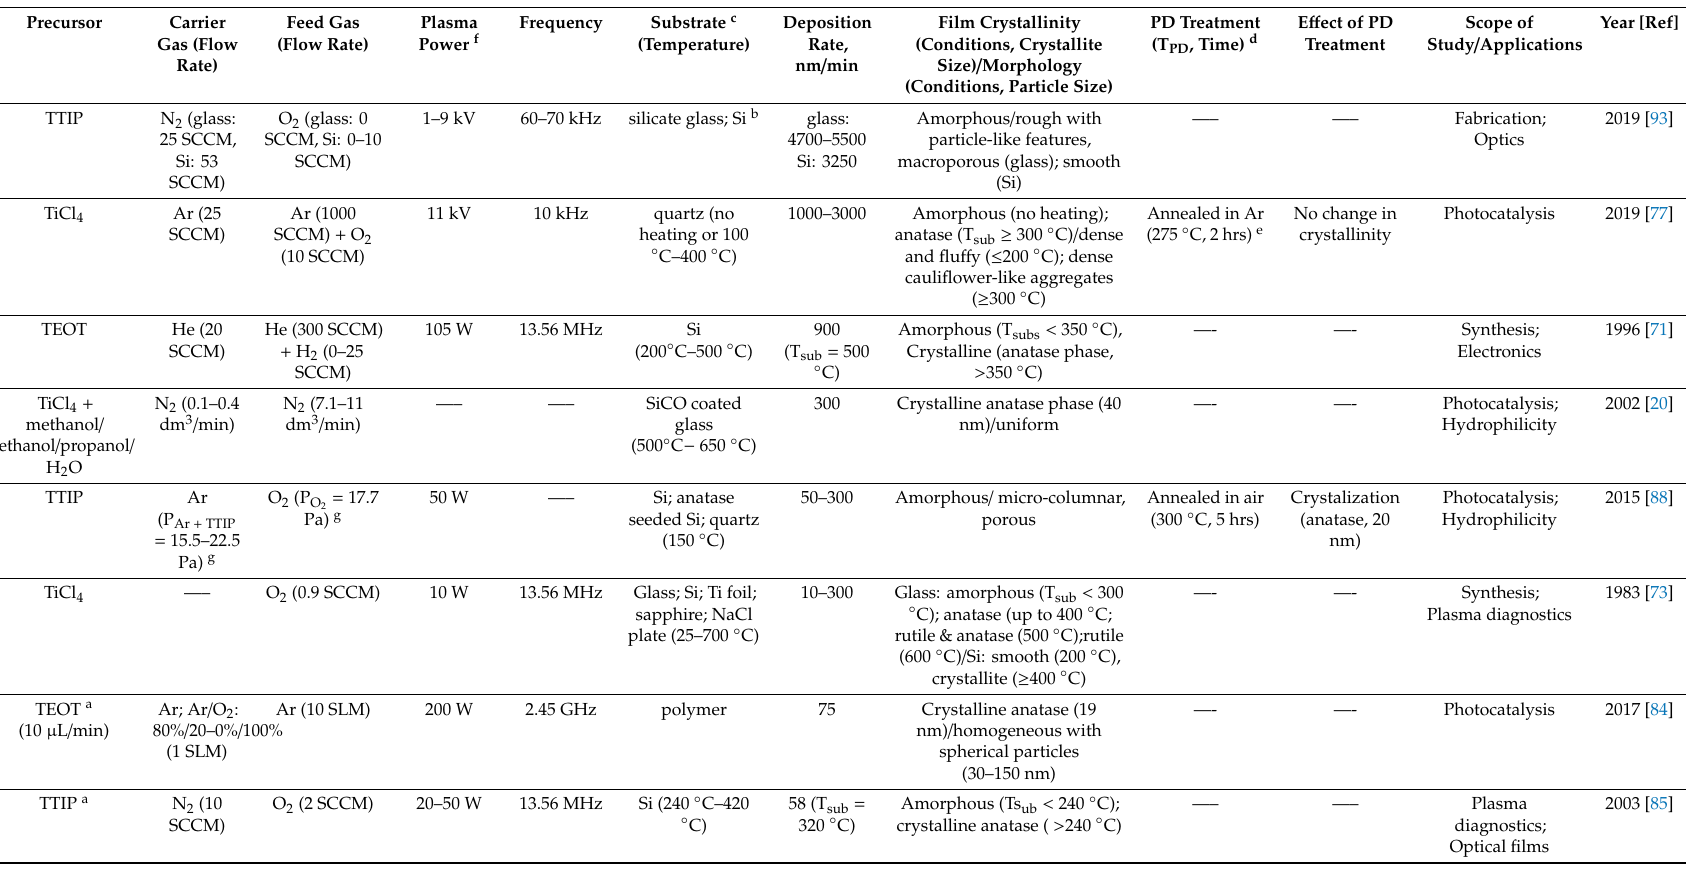
Table 1. Summary of deposition and plasma parameters, post-deposition treatment conditions, and their e ff ects on TiO 2 film morphology for PECVD. Studies are ordered in terms of decreasing deposition